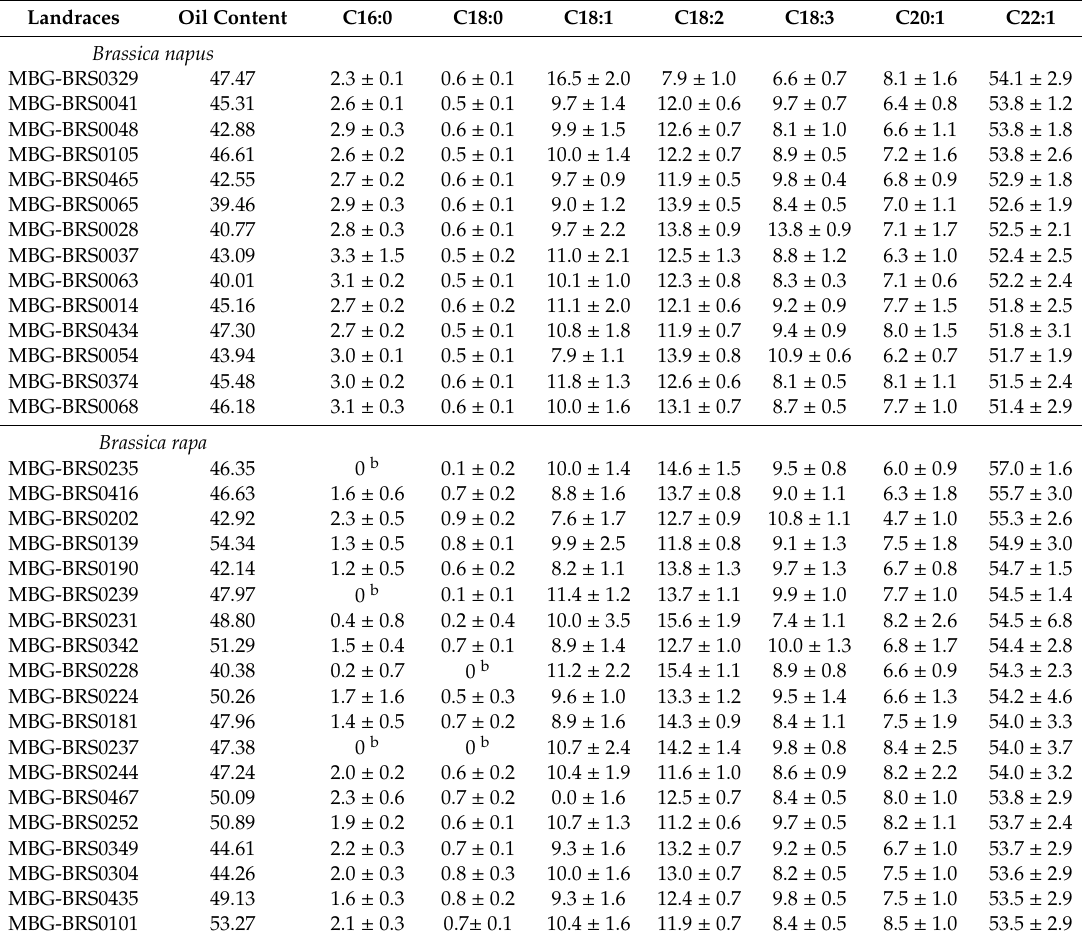
Table 4. Seed oil content and fatty acid composition a (major fatty acids) of B. napus and B. rapa landraces with the highest seed oil content and the highest erucic acid